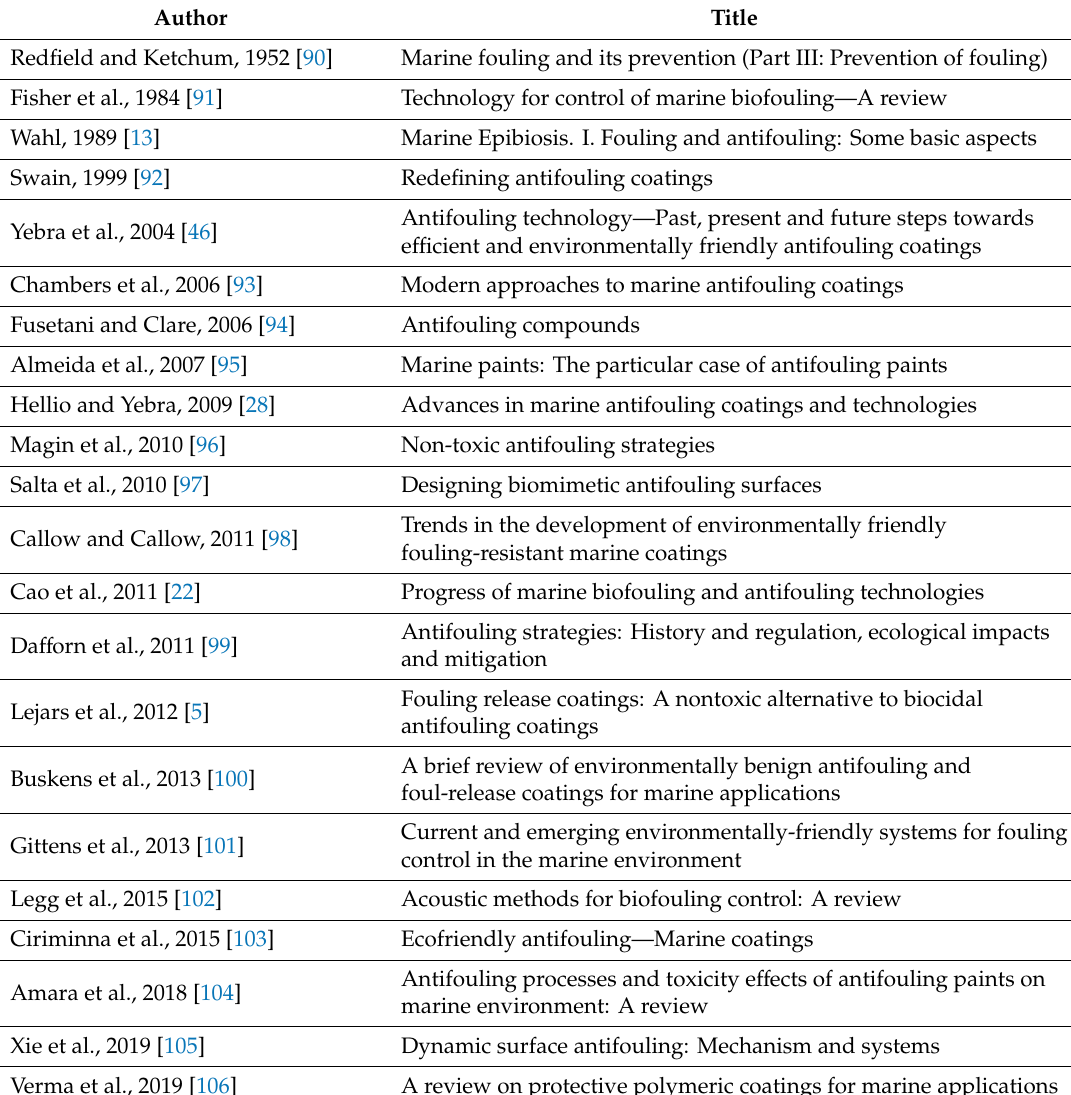
Table 1. Key reviews on the theme of biofouling control over the last 60